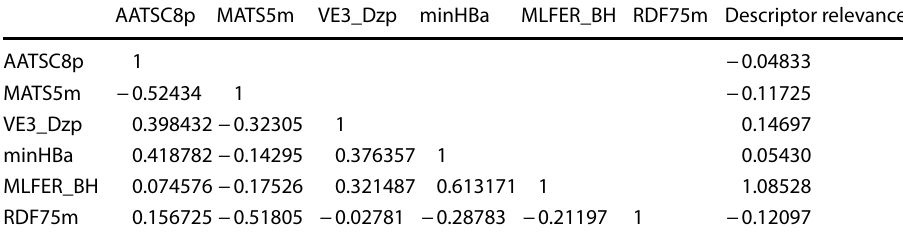
Table 3 Used molecular descriptor correlation matrix with mean effect